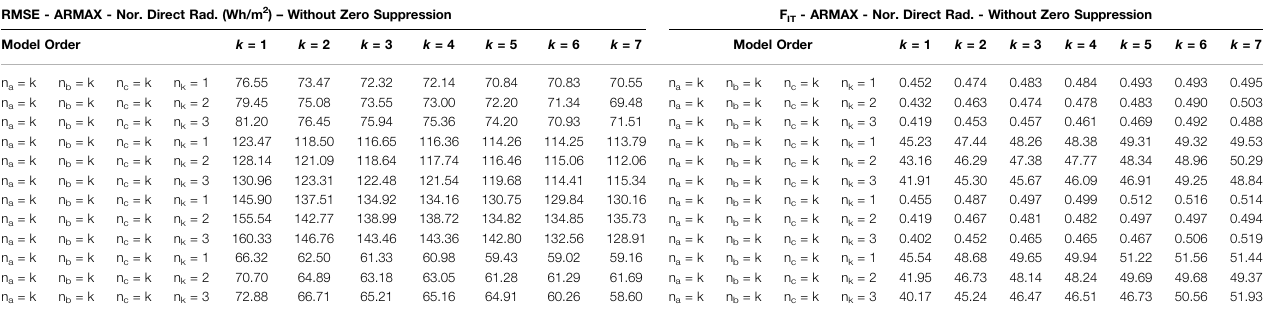
TABLE 6 | RMSE and F IT values for direct normal radiation model ARMAX. RMSE - ARMAX - Nor. Direct Rad. (Wh/m 2 ) – Without Zero Suppression F IT - ARMAX - Nor. Direct Rad. - Without Zero Suppression Model Order